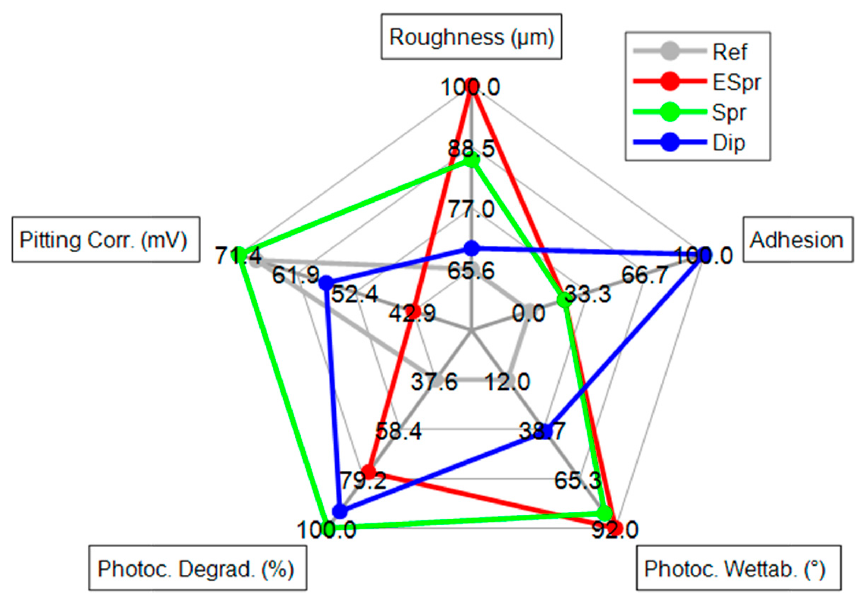
Figure 10. Five of the main features analyzed in this study resumed in a spider diagram for all photocatalytic samples on a scale from 0 to 100.